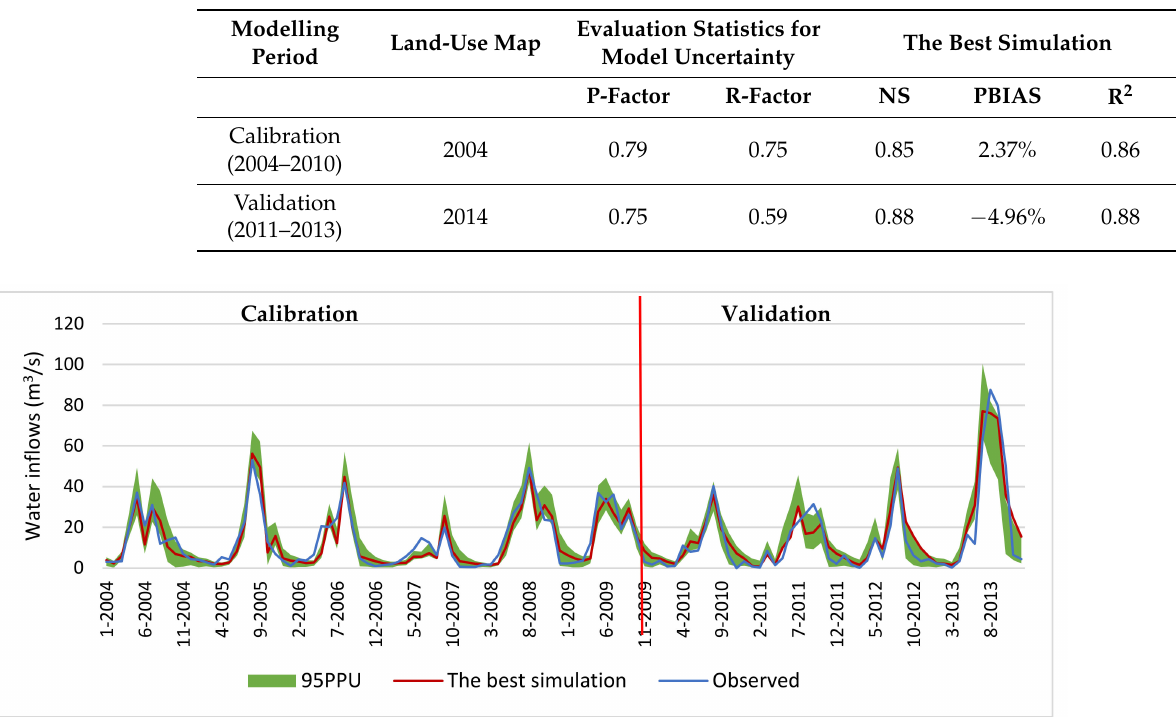
Table 2. The evaluation of SWAT model calibration and validation for water inflows.